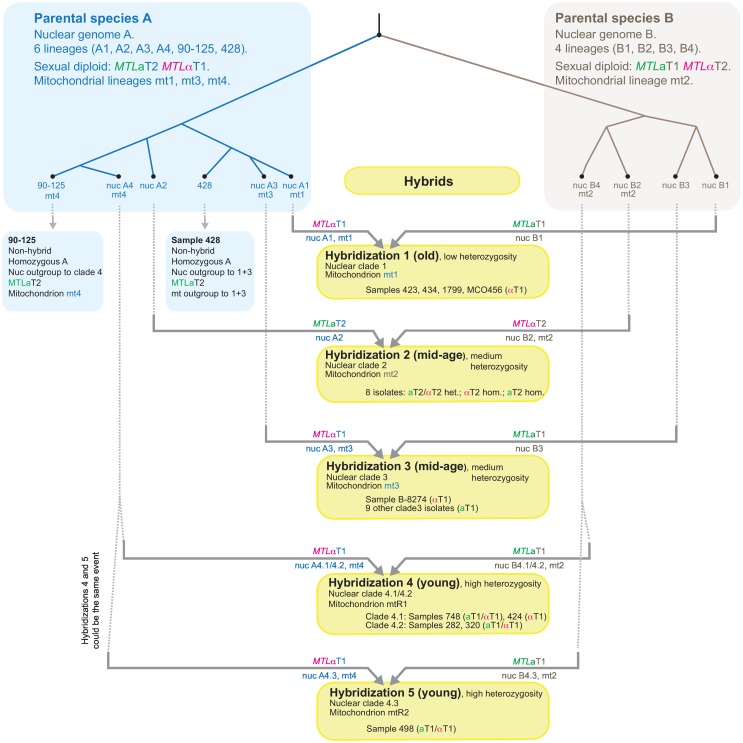
Multiple origins of the species Candida orthopsilosis by independent hybridization events.Each hybridization involved mating between cells of the same two parental species, A and B, which are 5% different in genome sequence. We propose that within species A and B, there are multiple distinct lineages. In species B we identify four lineages corresponding to the nuclear haplotypes B1-B4 found in hybrids. In species A we identify six lineages comprising the four nuclear haplotypes A1-A4 found in hybrids, and two found in the non-hybrid strains 90–125 and 428. The inferred mitochondrial (mt) mitotypes of each parental lineage are shown where known. The five yellow boxes represent the five separate hybridization events we propose, with the genomic contributions from parents A and B indicated on the horizontal arrows (mitotypes, nuclear haplotypes, and MTL genotypes). See text for details of the proposed hybridization events.